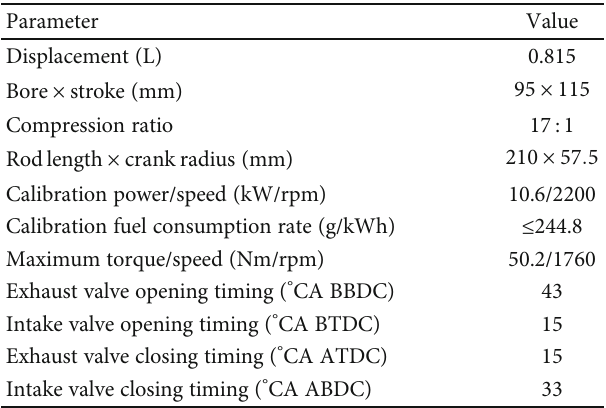
Table 1: Main parameters of test